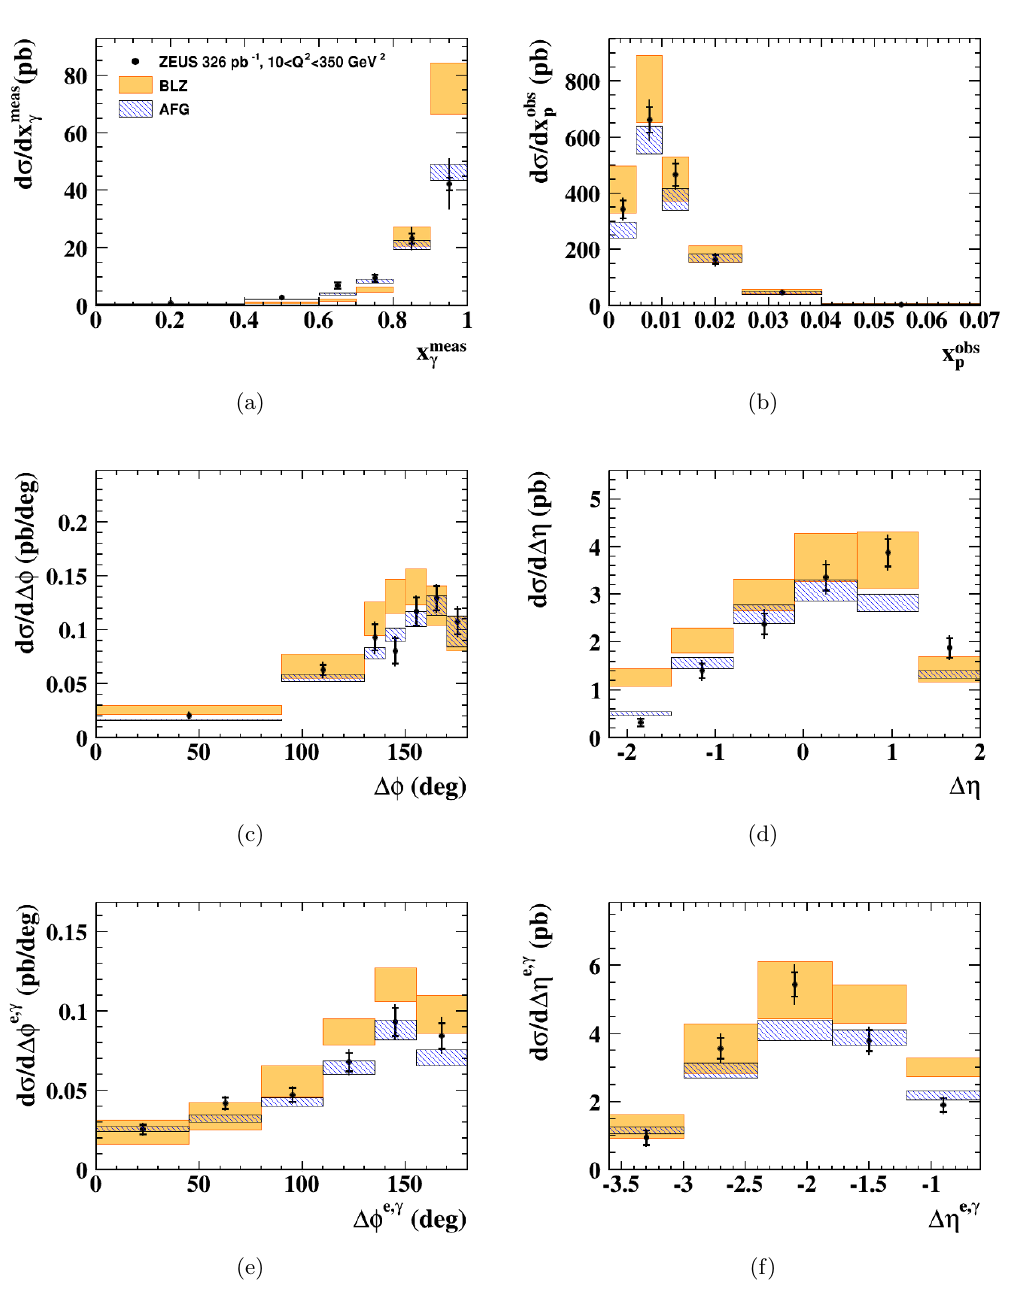
Figure 7 . Di(cid:11)erential cross sections for selected variables in the full Q 2 range 10 < Q 2 < 350 GeV 2 : as in (cid:12)gure 3. Theoretical predictions from Aurenche et al. (AFG) and Baranov et al. (BLZ) are shown, with scale uncertainties indicated by the bands.